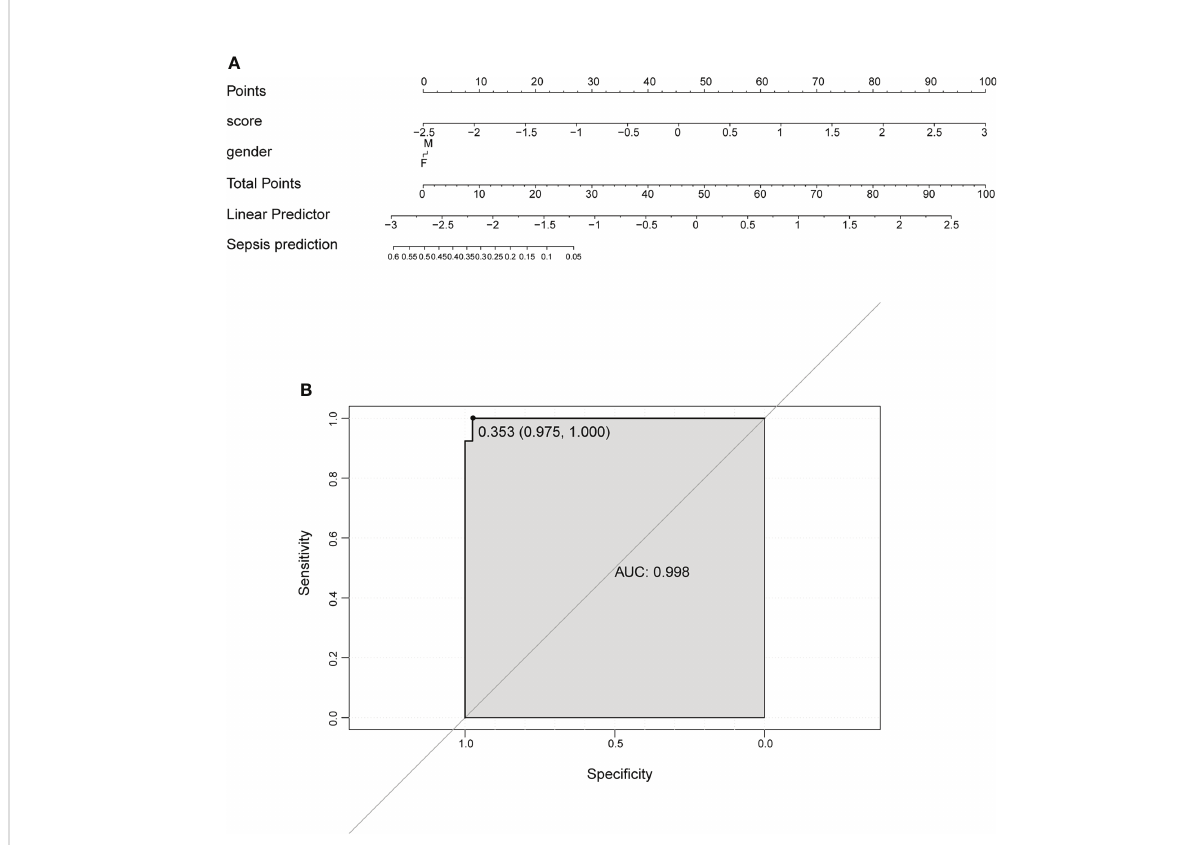
FIGURE 6 Nomogram to predict the occurrence of sepsis. (A) Prognostic nomogram. (B) ROC curve to evaluate the performance of the nomogram. ROC, receiver operating